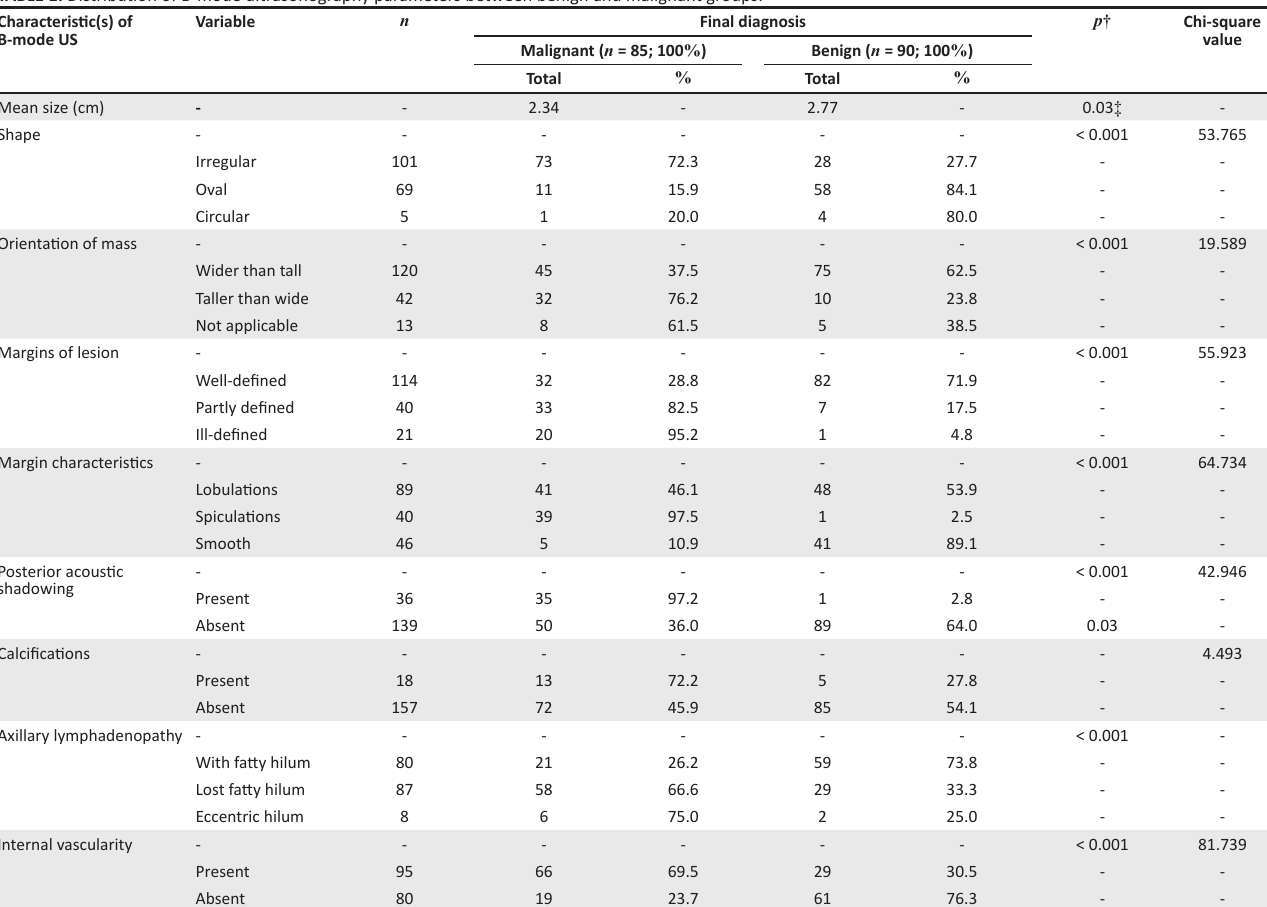
TABLE 1: Distribution of B-mode ultrasonography parameters between benign and malignant groups. Characteristic(s) of Variable B-mode US